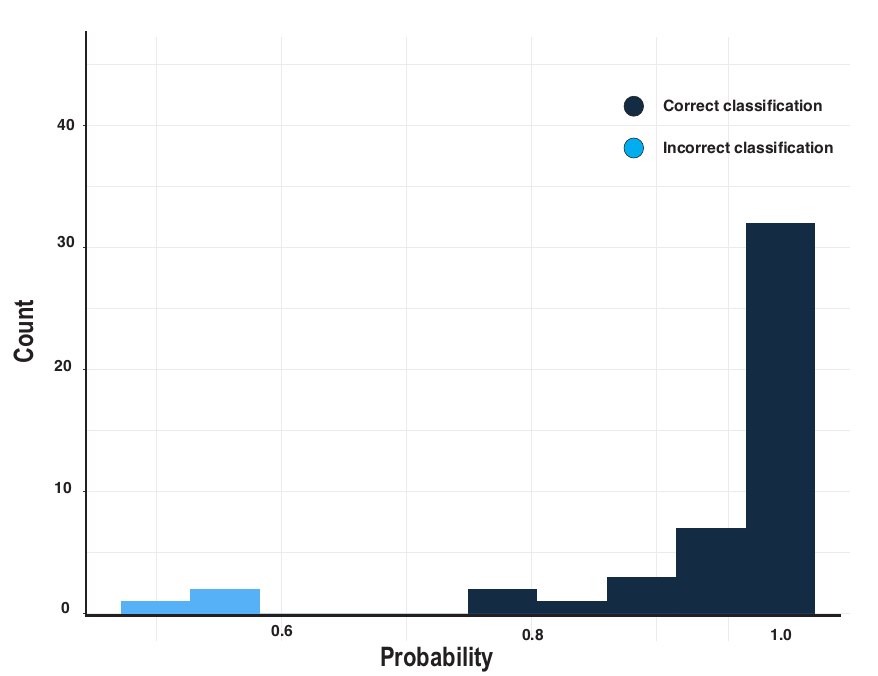
Figure 5. Probability counts for DNN model prediction. Dark blue presents the correct classification; Light blue presents the incorrect